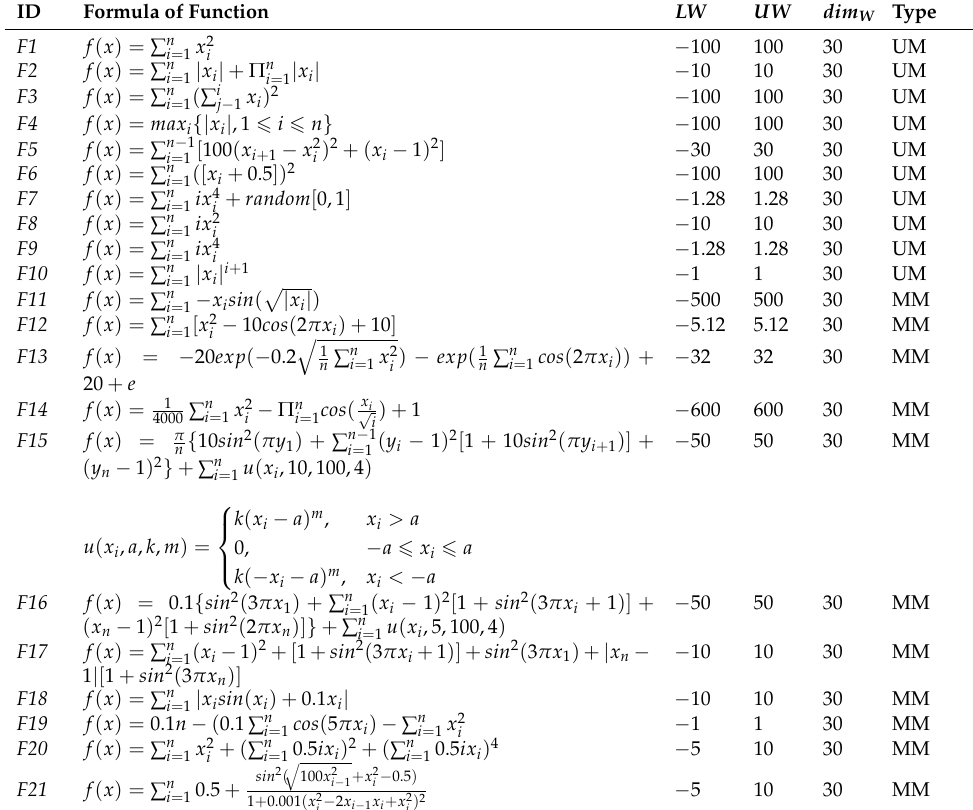
Table 2. Formulation of global